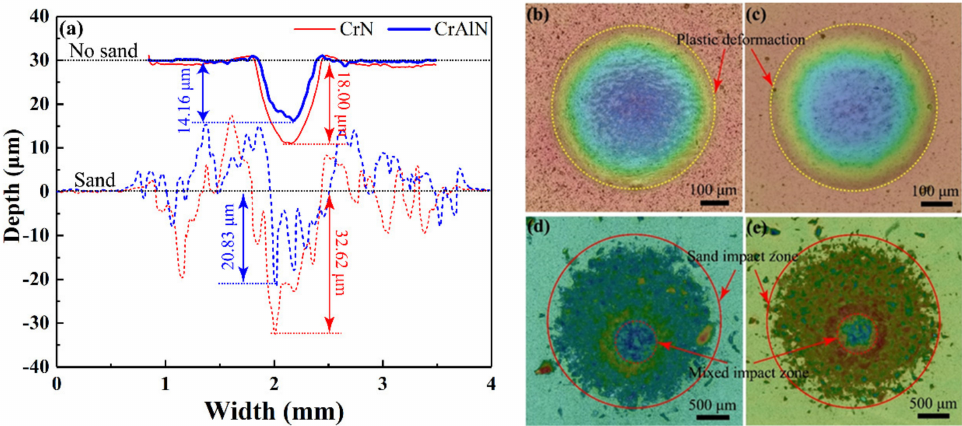
Figure 9. Impact wear scar profile and surface cloud chart of CrN and CrAlN coating under 500 ◦ C in sand and no − sand conditions: ( a ) Wear scar profile; ( b , d ) CrN coating in sand and no − sand condition; and ( c , e ) CrAlN coating in sand and no-sand